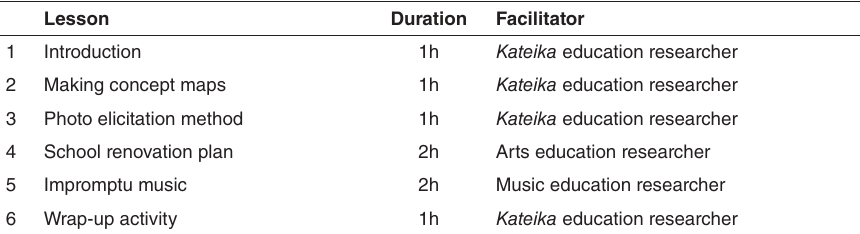
Table 3: Lessons and